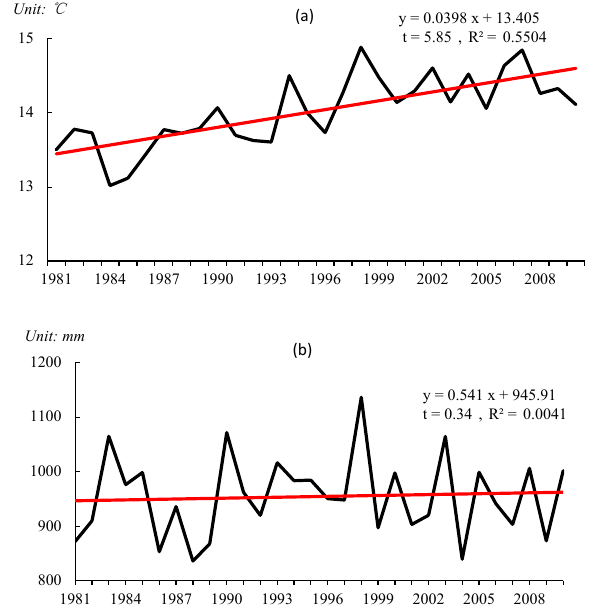
Figure 1. Change of annual temperature and precipitation in the last 30 years (1981–2010): (a) Change of annual temperature; (b) Change of annual precipitation. Data sources: National Mete- orological Information Center in